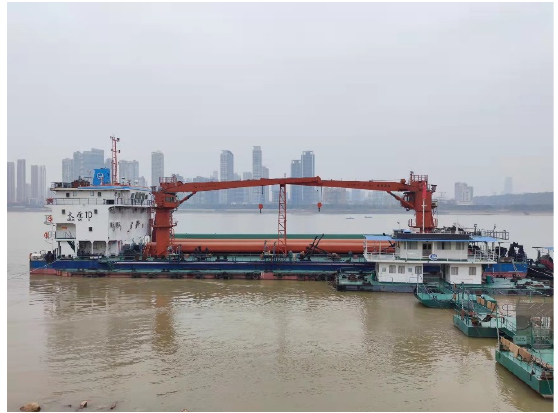
Figure 1. Satellite image of Wuhan City (source of base map: Resource Satellite 3).